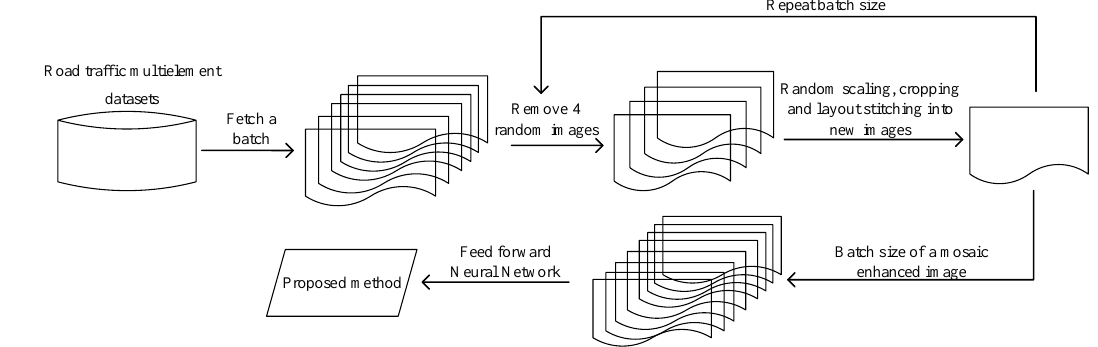
Figure 4. Workflow of mosaic data augmentation.